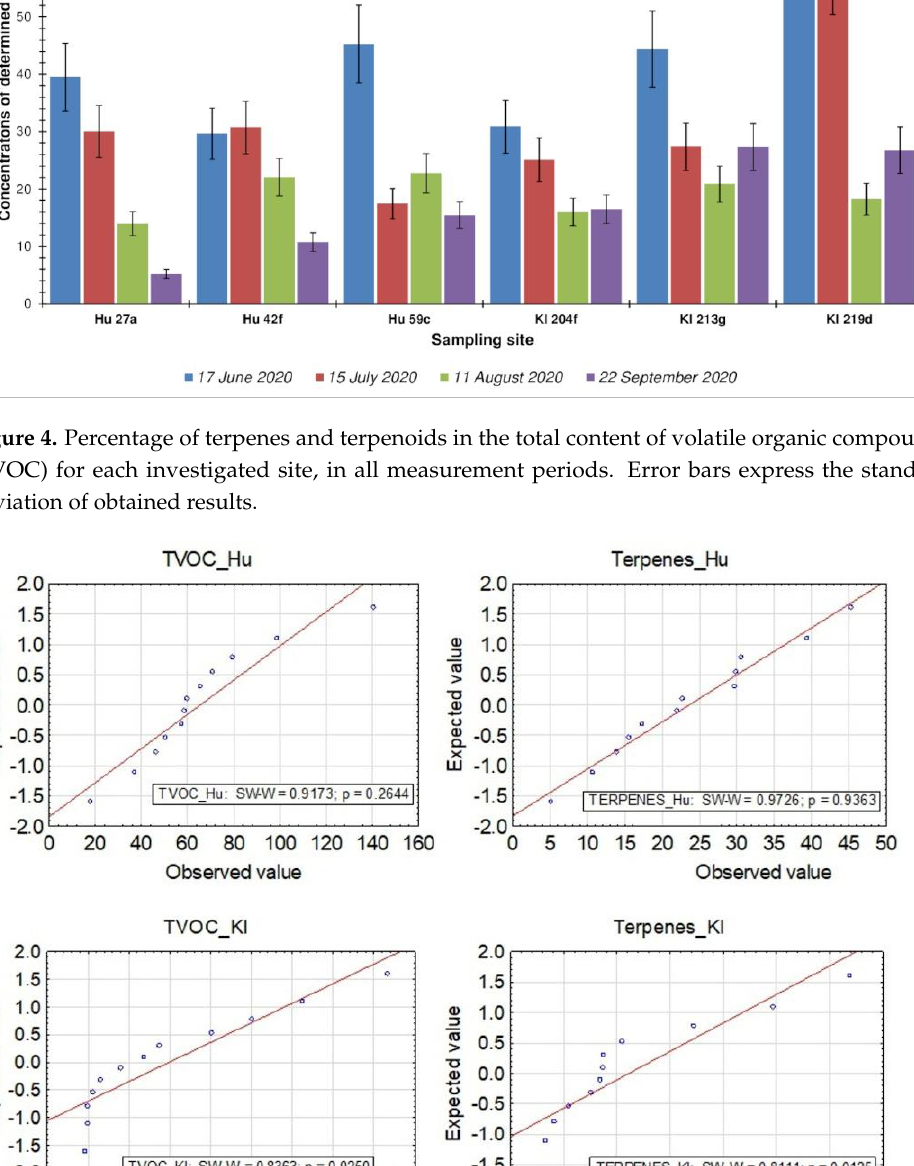
Figure 4. Percentage of terpenes and terpenoids in the total content of volatile organic compounds (TVOC) for each investigated site, in all measurement periods. Error bars express the standard deviation of obtained results.